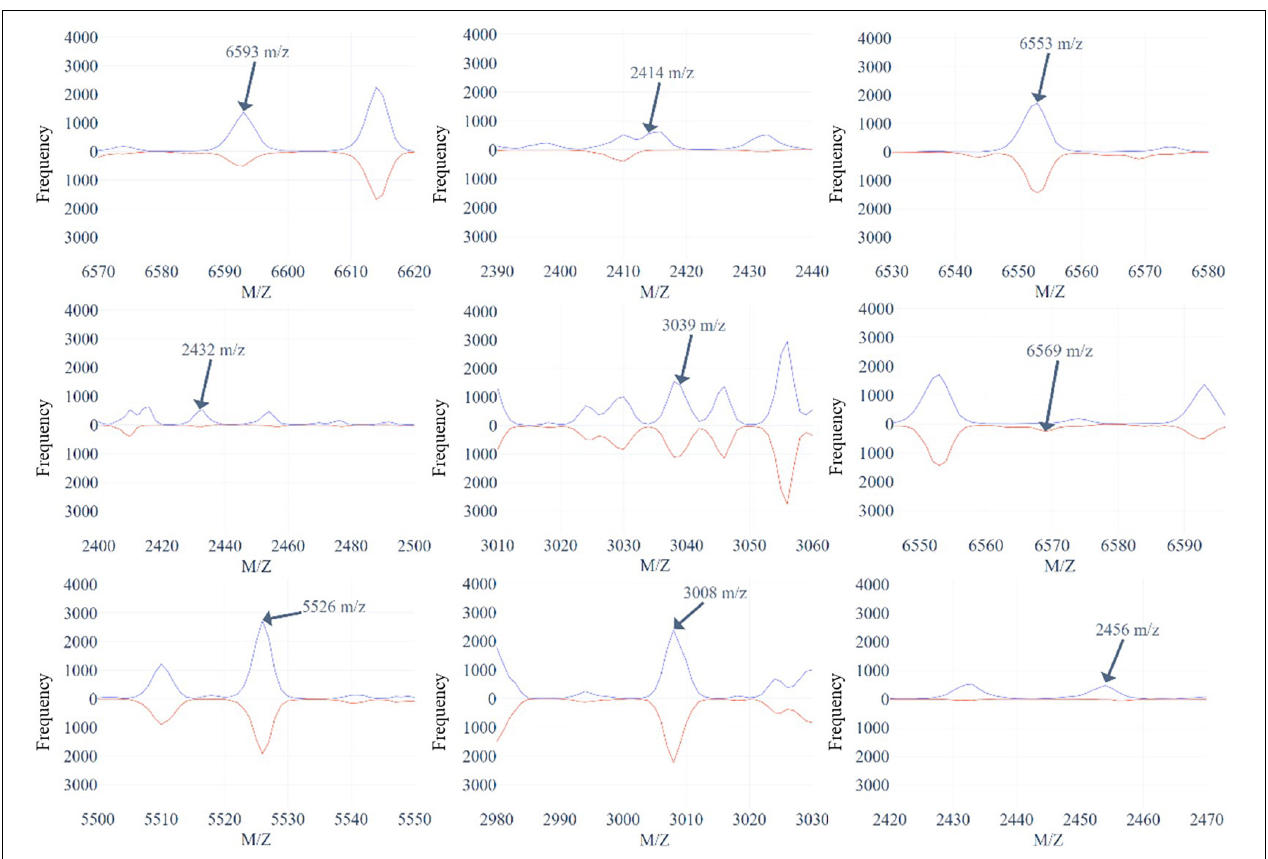
FIGURE 5 | The top 9 selected peaks distributions of the M/Z values without peaks alignment for oxacillin-resistant (red)/susceptible (blue)